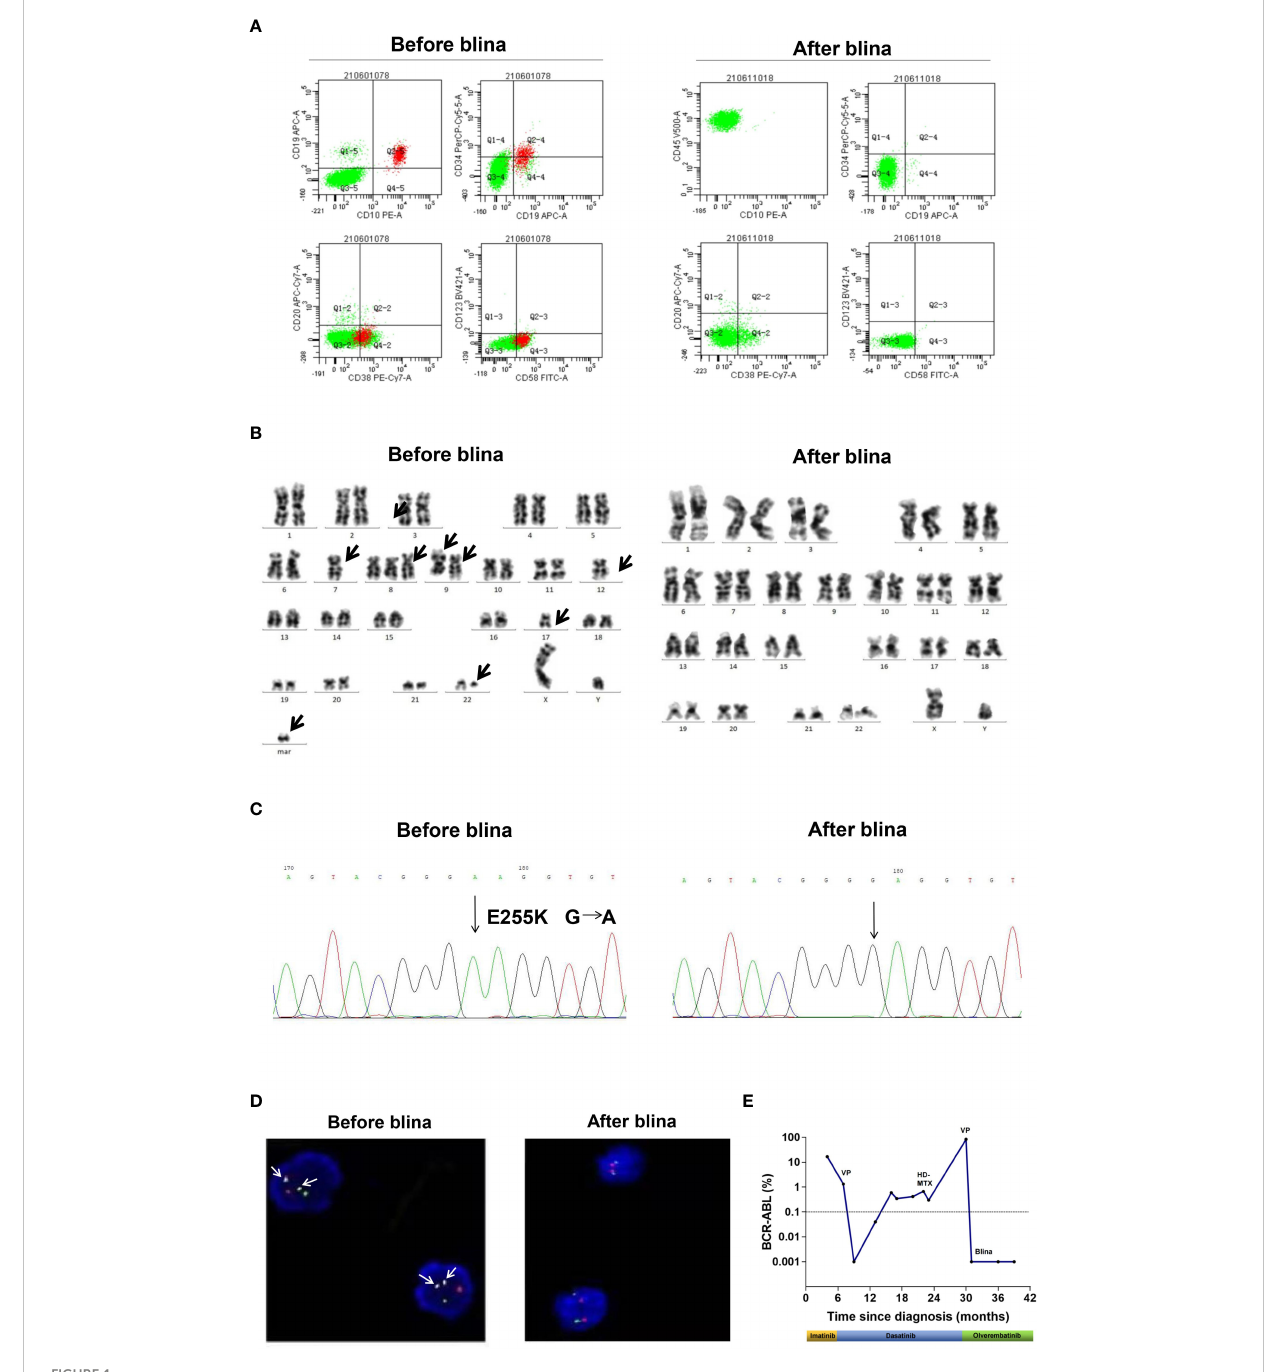
FIGURE 1 Clinical data of case 1. (A) Flow cytometry analysis of cerebral spinal fl uid (CSF) before and after blinatumomab (blina). (B) G banded chromosome analysis before and after blina. (C) Sanger sequencing of ABL1 kinase domain before and after blina. (D) Fluorescence in situ hybridization (FISH) analysis of BCR::ABL1 fusion before and after blina. (E) Timeline of treatments and responses of case 1. VP, vincristine 1.5 mg/m 2 intravenously, per week for 4 times and prednisolone 1 mg/kg, once daily, for 4 weeks; HD-MTX, MTX 3.5 g/m 2 , intravenously, for one